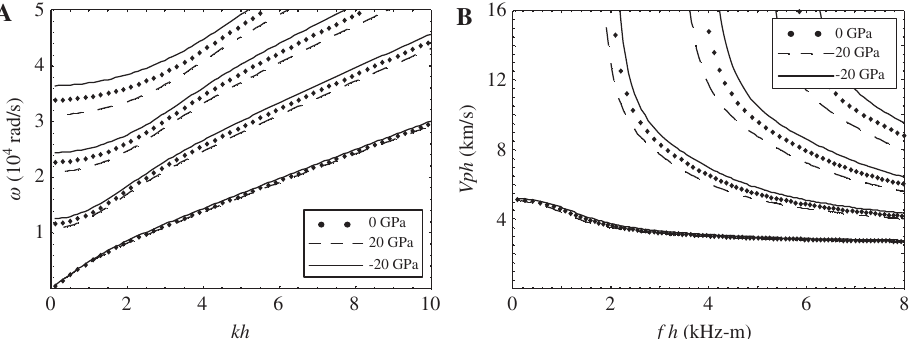
Figure 7 Circumferential SH wave dispersion curves for the linearly graded cylindrical plate with η = 2 under different radial initial stresses: (A) frequency spectra, (B) phase velocity spectra.